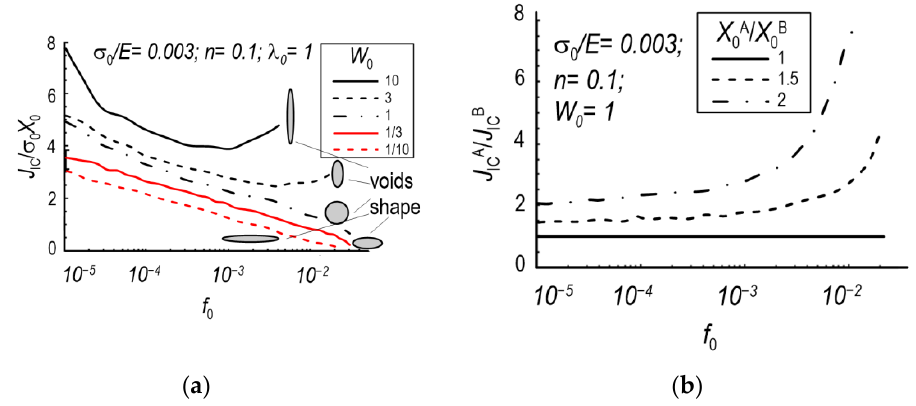
Figure 16. Dependence of fracture toughness level on initial porosity: ( a ) Depending on the initial shape of the void; ( b ) Depending on the anisotropic void spacing [130].